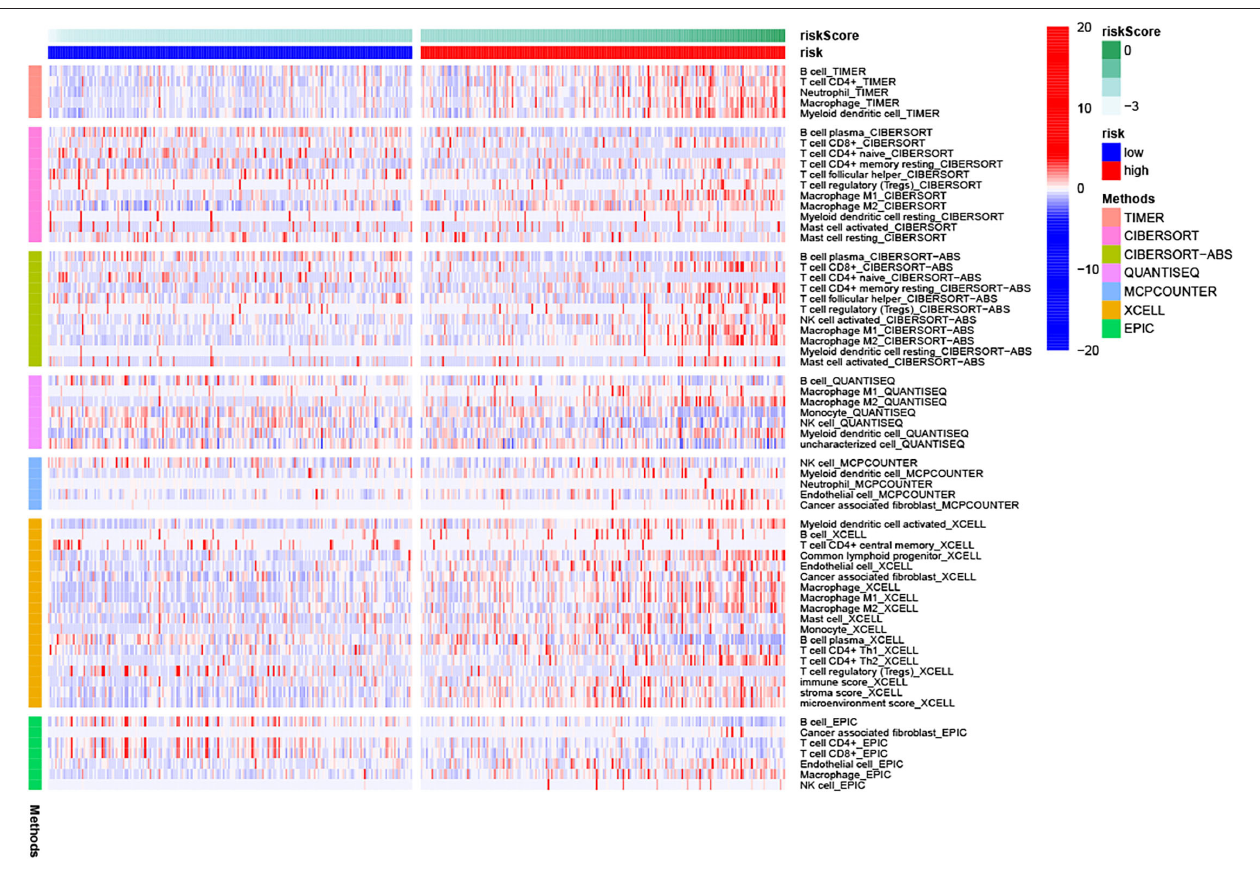
FIGURE 9 | Immune cells and immune responses based on several algorithms.